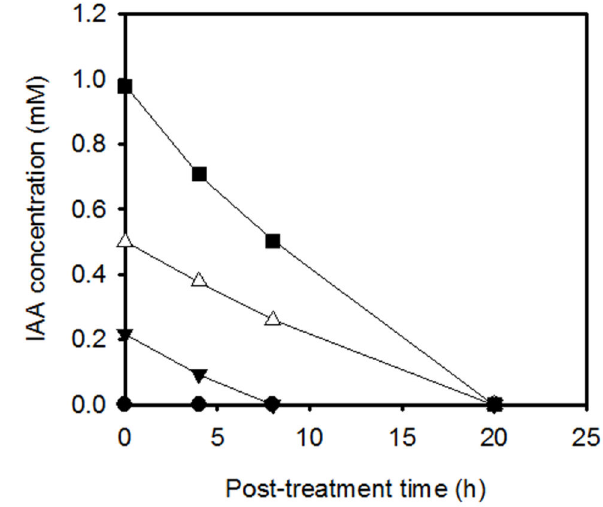
Figure 2. The concentration of IAA in the supernatant plotted as a function of